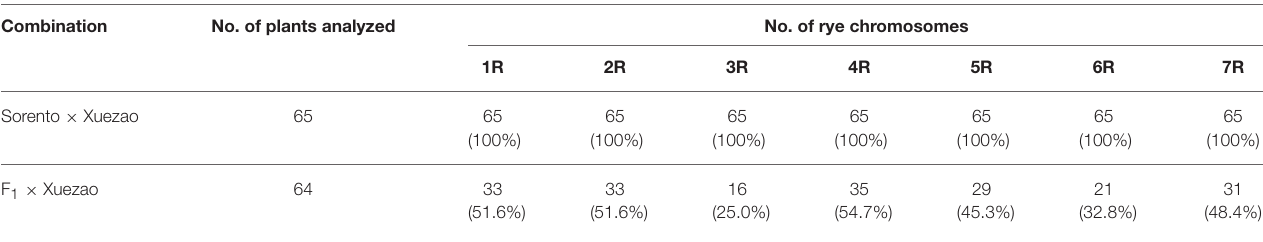
TABLE 2 | Transmission rate of individual rye chromosome in F 1 and BC 1 F 1 through female gametes.